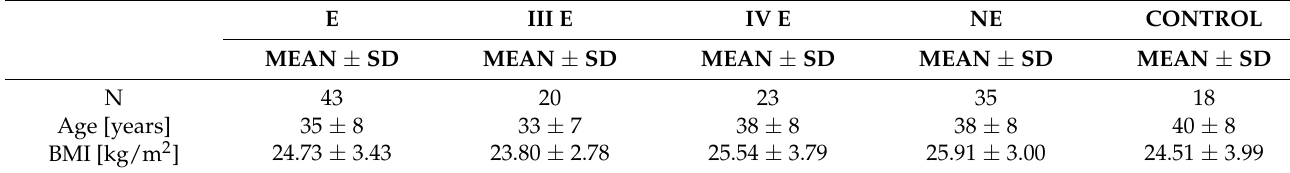
Table 3. The characteristics of study